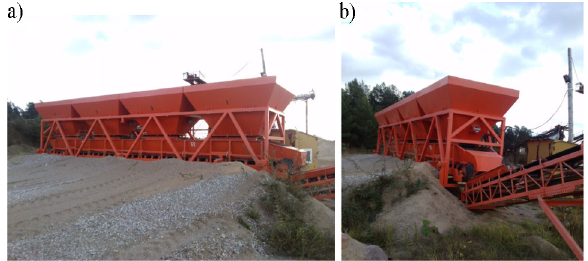
Uniformity Rate of coefficient curvature c u C